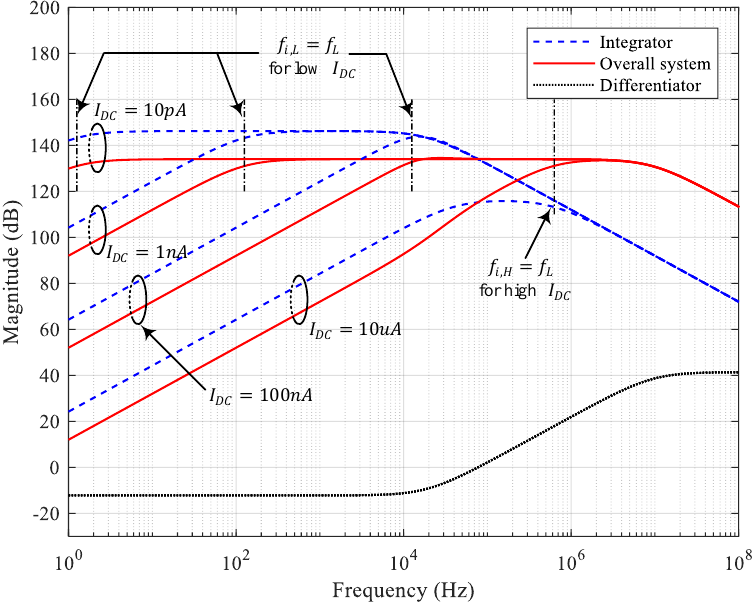
Figure 4. Transfer functions of the integrator, differentiator, and overall system placing C 2 = 40.8 pF such that γ = 1 for I dc = 10 pA, 100 nA, 1 nA, and 10 uA, where C µ = 1 pF, C µ , c = 1 pF, G c = 50, C f = 0.2 pF, C d = 1 nF, C c = 8.51 pF, R d = 2 k Ω , R 2 = 8.16 k Ω , C 1 = 10 nF, and R 1 = 100 k Ω